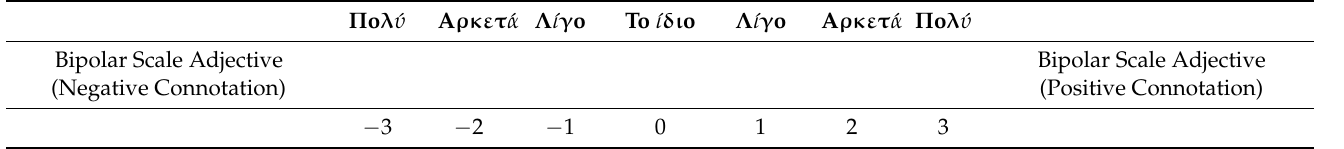
Table A2. More about an appropriate translation of scales and attributes can be found in [70]. Table A2. Seven-point bipolar scale (Greek).